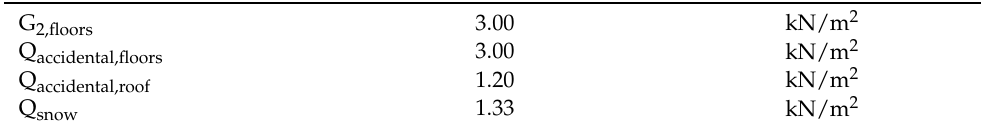
Table 8. Beam and column cross-sections of the multi-storey case studies after vertical static analysis design.